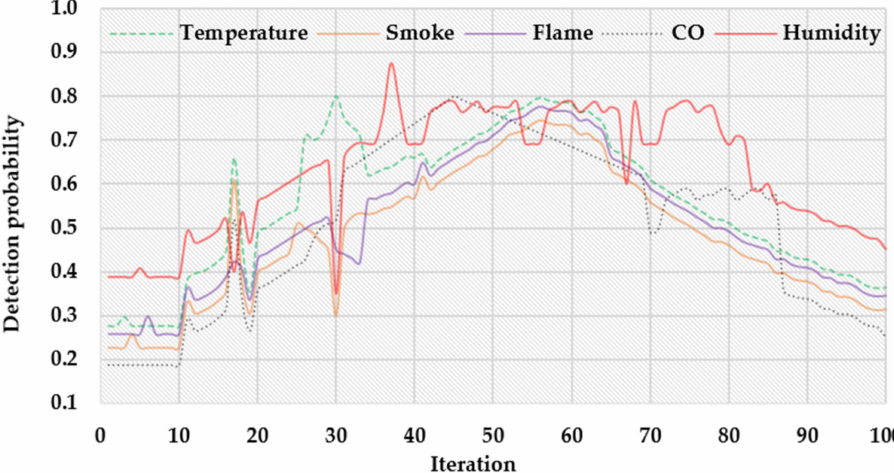
Figure 5. The detection probability of fire is based on the respective context.